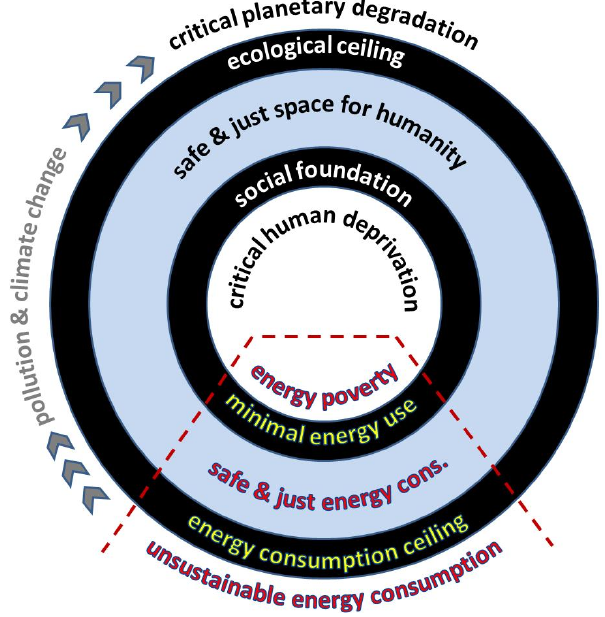
Figure 3. The “energy consumption doughnut”, adapted from "The doughnut of social and planetary boundaries” (K. Raworth & C. Guthier. CC-BY-SA 4.0) [70].